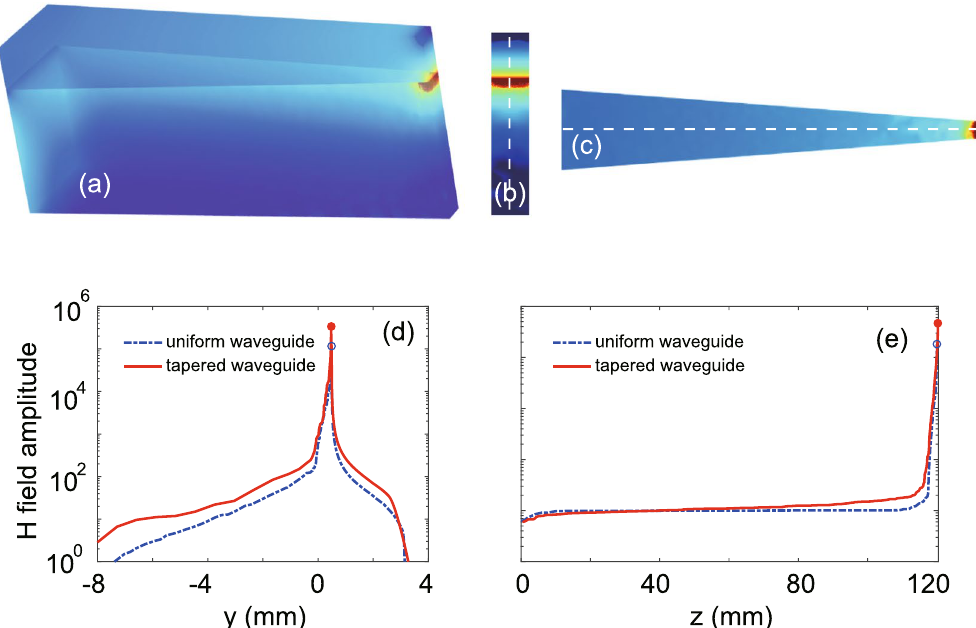
Figure 8. ( a ) Simulated H amplitudes in the tapered system for trapping wave. ( b ) Vertical cutting slice in ( a ) at z = 119.96 mm, where the center of the hotspot is located. ( c ) Horizontal cutting slice in ( a ) at y = 0. ( d ) and ( e ) Distributions of H amplitude along the central lines in ( b and c ), respectively. The dash-dotted lines in ( d and e ) correspond to the results in Fig. 3(b,c) for the system with uniform waveguide. The solid and open circles indicate the peaks of field profiles for the tapered and uniform systems, respectively. In the tapered system, the waveguide width is linearly reduced from 5 mm to 1 mm over the waveguide length of 120 mm. The other parameters are the same as in Fig.